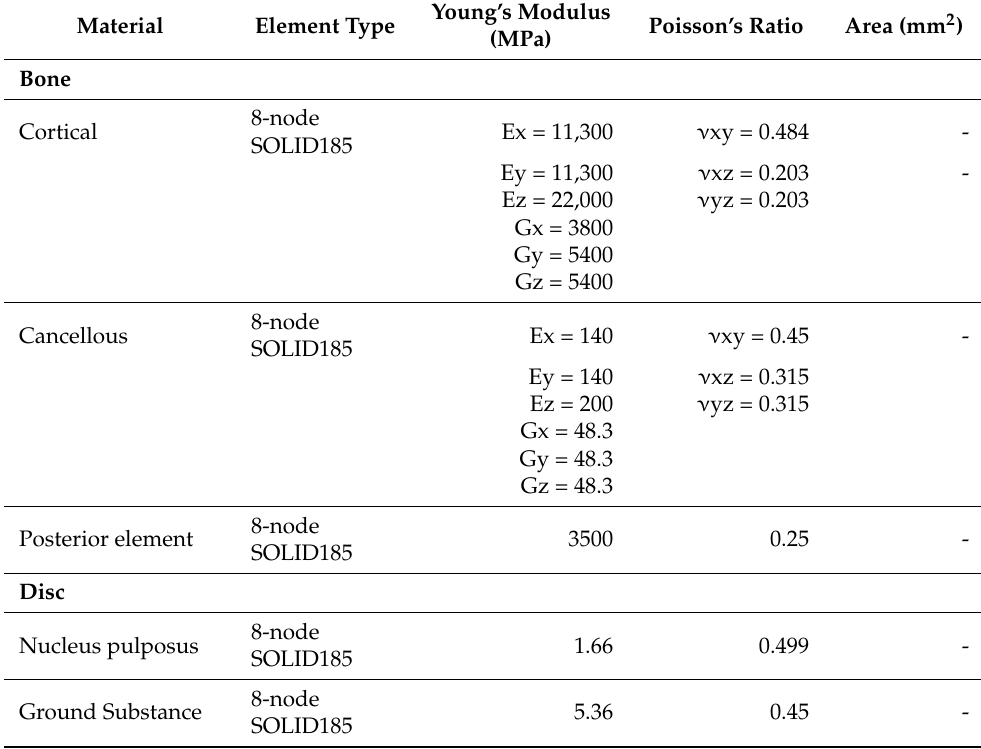
Figure 1. FE model of intact lumbar spine. Note: ALL = anterior longitudinal ligament; CL = capsular ligament; ISL = interspinous ligament; LF = ligamentum flavum; PLL = posterior longitudinal ligament; SSL = supraspinous ligament; TL = transverse ligament. Table 1. Material properties of lumbar spine.